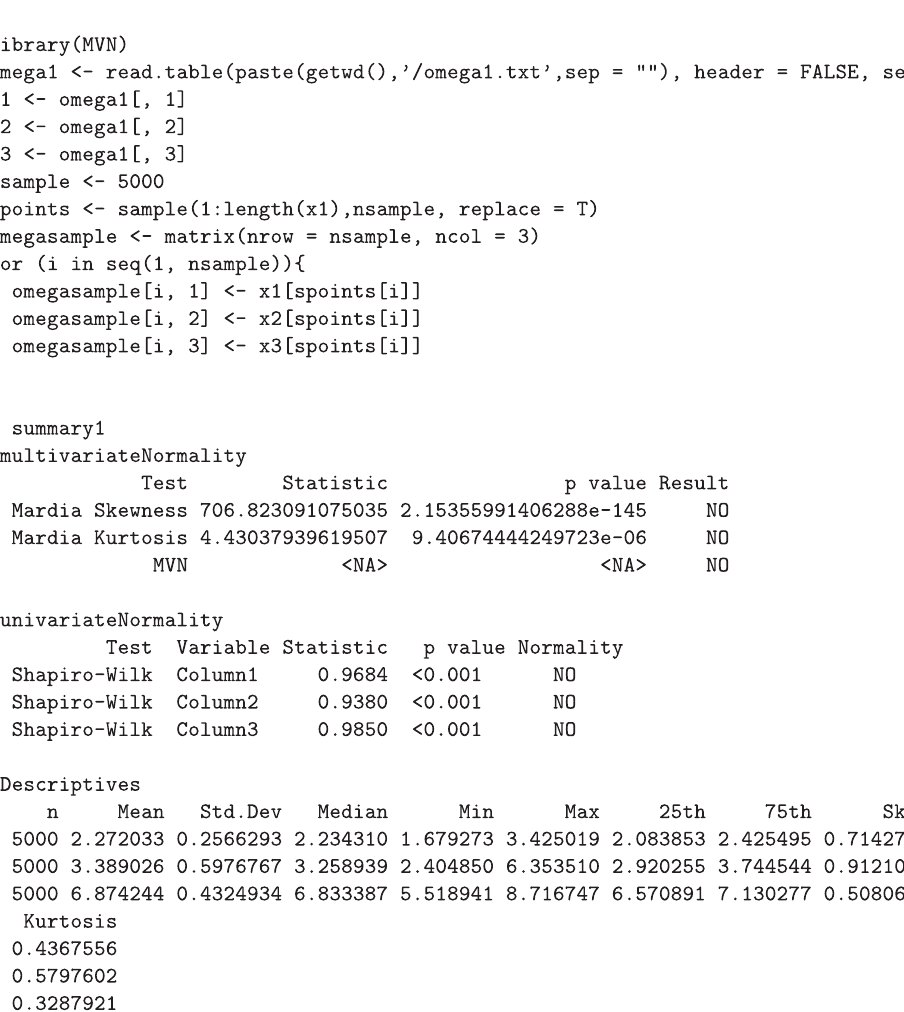
Fig. 4. Statistical summary of multivariate non-Gaussian characteristics of the GUM supplement 2 Monte Carlo data using the Mardia normality